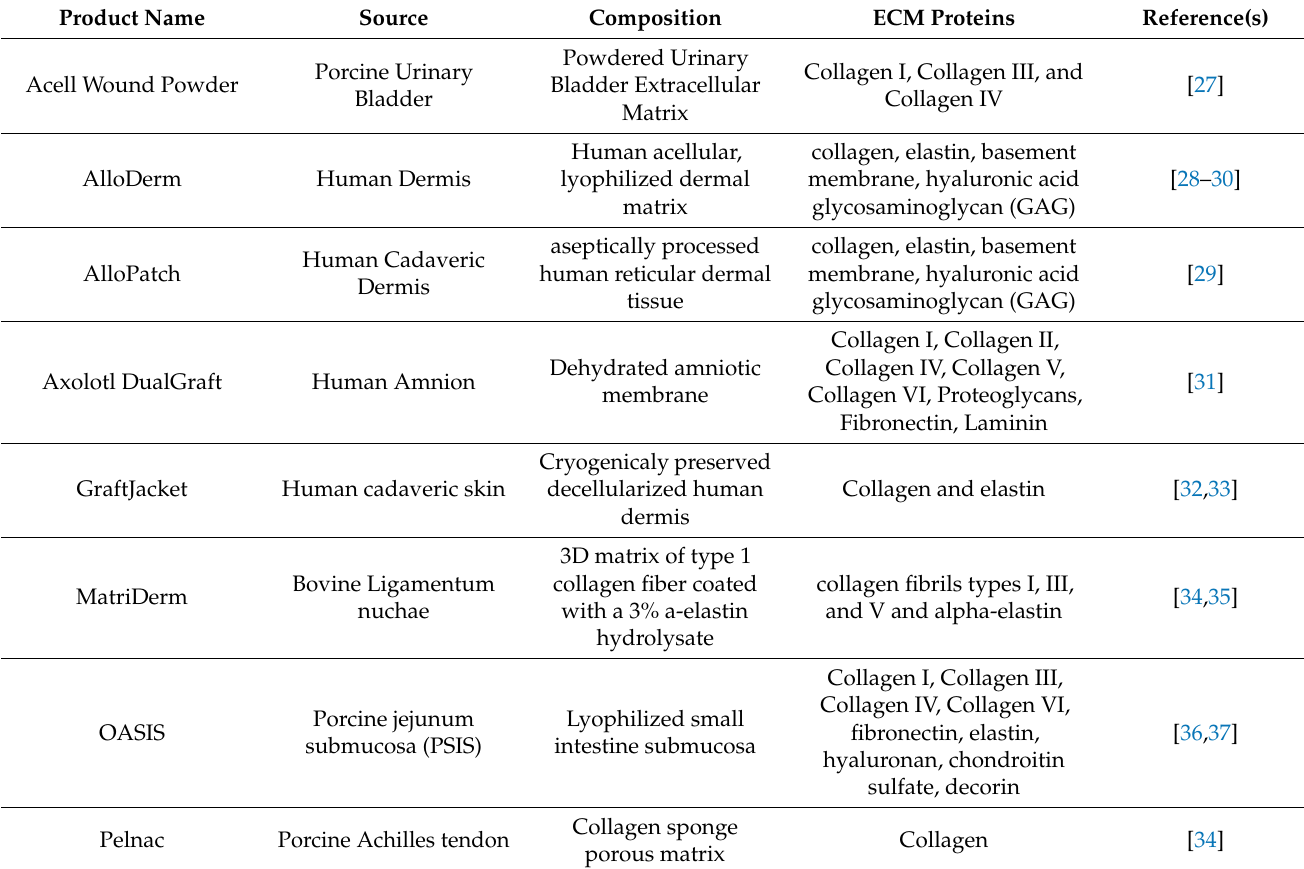
Table 1. A list of wound healing products created using ECM proteins and a list of medical devices manufactured from synthetic polymers, intended to mimic the ECM. These lists are not meant to be all inclusive, but instead provided the reader with several examples of products which utilize ECM proteins to assist in wound healing, and products which attempt to mimic the structure of the dermis to influence wound